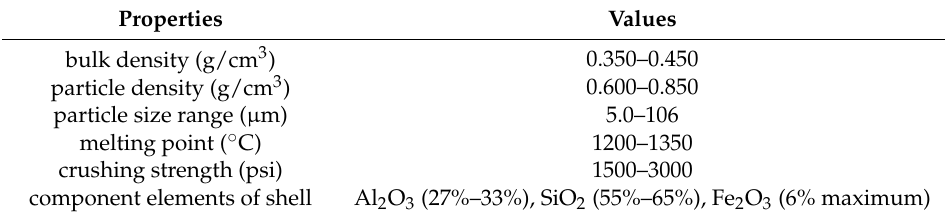
Table 3. The datasheet of Omya Fillite ® FG (106) alumino-silicate cenospheres